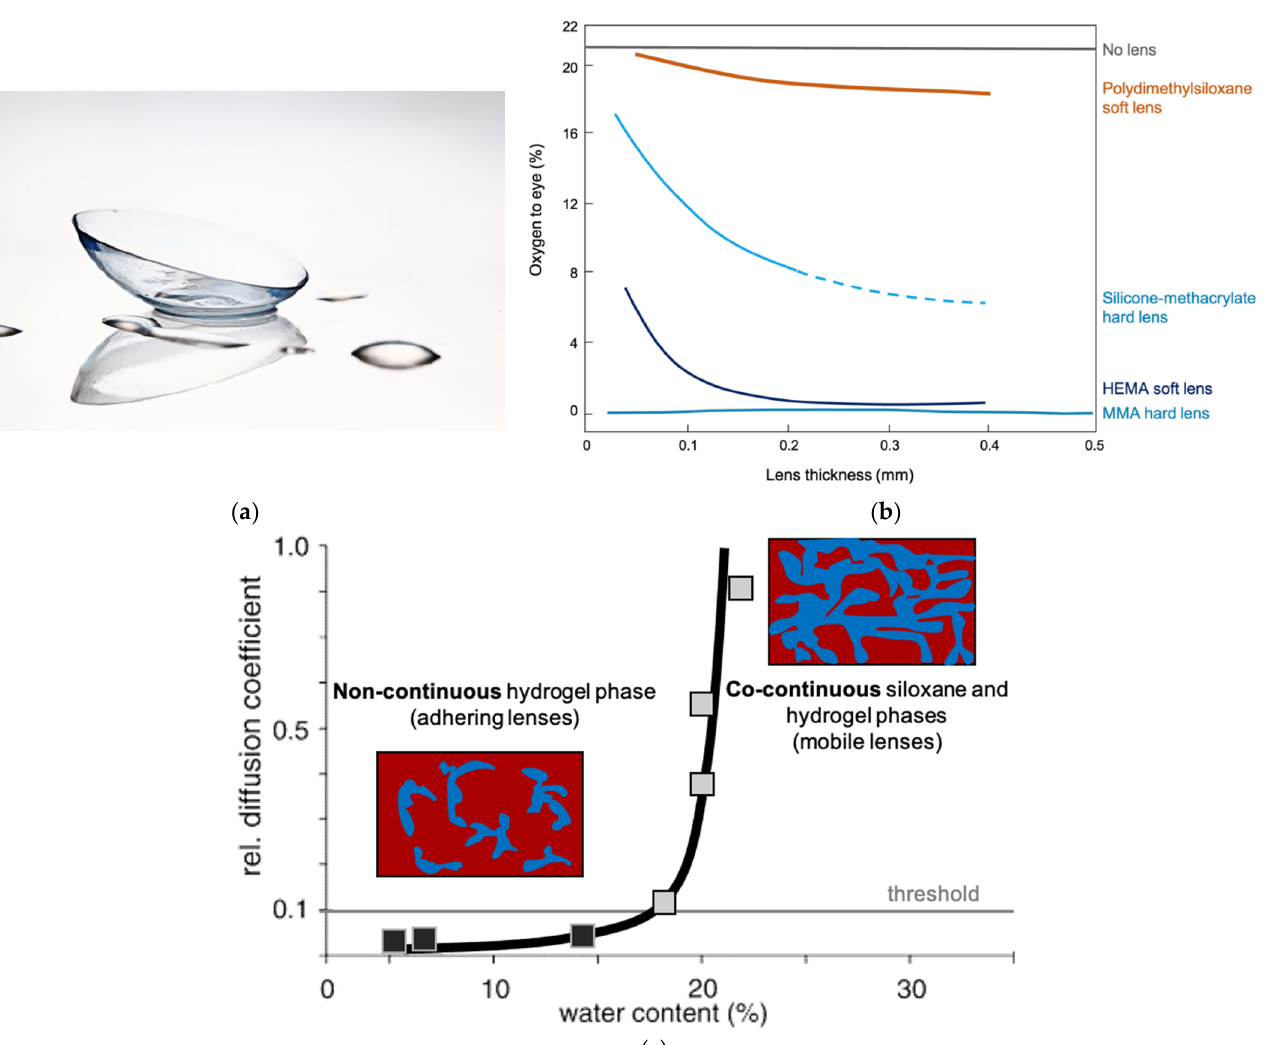
Figure 4. ( a ) Silicone hydrogel lenses incorporate low MW macromers into otherwise hydrophilic matrices based on hydroxyethylmethacrylate or dimethylacrylamide; ( b ) comparison of contact lens materials and oxygen transport to the cornea (redrawn with permission from Ref. [122] Copyright 1983 the Technomic Publication). ( c ) Hydrogel phase structure as a determinant of lens comfort (redrawn with permission from Ref. [121] Copyright 2001 Elsevier Science).